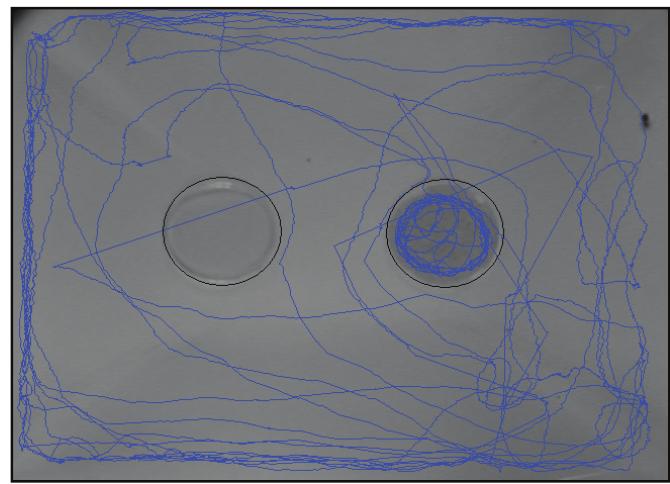
Figure 5. A representative image showing the movement pattern of a single Plodia interpunctella female for a 30-min period during the first 2 h of the scotophase. The experiment was a two-choice bioassay with an empty dish control (left); and a food dish (right) containing 2 g of cracked soybean.